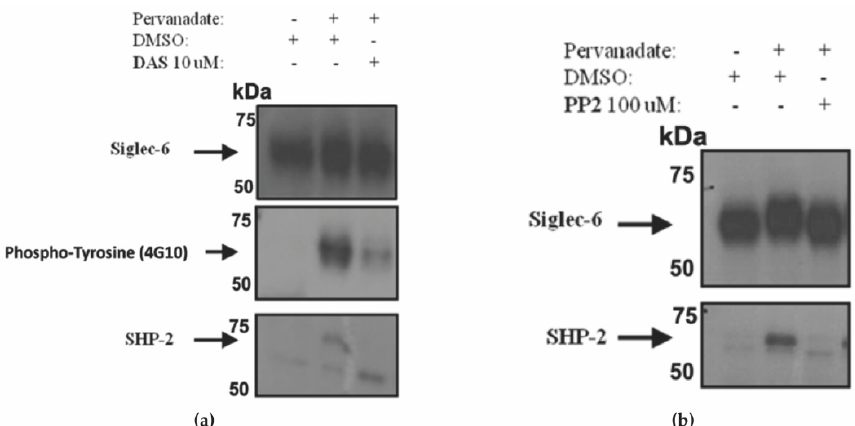
Figure 6. Inhibition of Src-kinases Prevents Siglec-6 Phosphorylation and SHP-2 Recruitment. HTR- 8/SVneo cells stably transfected with Siglec-6 or pCDH control were treated with PBS (control) or pervanadate in conjunction with ( a ) one-hour pretreatment with DMSO or DAS. Anti-Siglec- 6 immunoprecipitates were immunoblotted with anti-Siglec-6, anti-phosphotyrosine (4G10), and anti-SHP-2 antibodies. ( b ) HTR-8/SVneo lysates from cells pretreated with DMSO or PP2 were immunoprecipitated and immunoblotted with anti-Siglec-6 and anti-SHP-2 antibodies ( n =